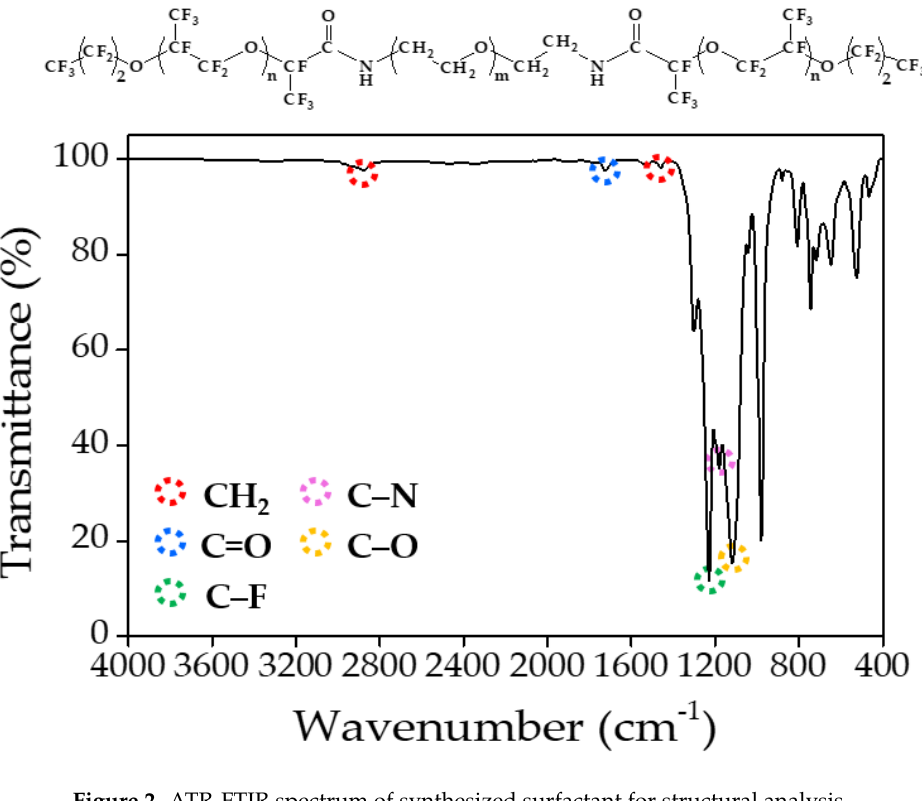
Figure 2. ATR-FTIR spectrum of synthesized surfactant for structural analysis.